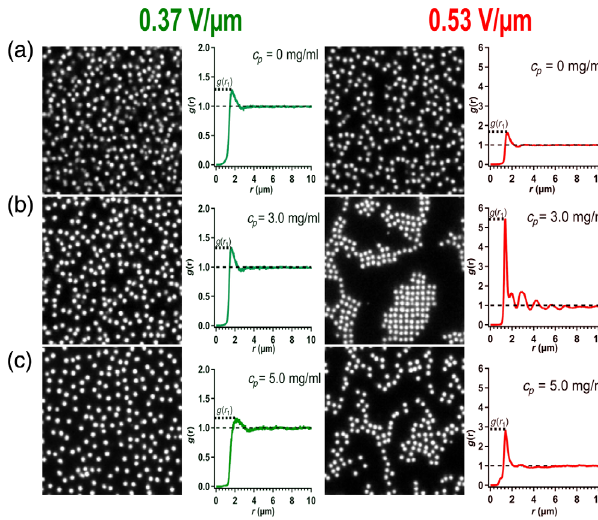
FIG. 1. Confocal images and radial distribution function [ g ð r Þ ] at different field strengths E . g ð r Þ is analyzed for a sequence of 100 ( 256 × 256 pixels) images. A region of interest of size 128 × 128 pixels is shown (each pixel has an ¼ 0 mg = ml at E ¼ 0 . 37 and extent of 0 . 276 μ m). (a) c p 0 . 53 V = μ m. (b) c ¼ 3 mg = ml at E ¼ 0 . 37 and 0 . 53 V = μ m. p ¼ 5 mg = ml at E ¼ 0 . 37 and 0 . 53 V = μ m. Height of the first (c) c p peak of g ð r Þ denoted by g ð r 1 Þ in the graphs varies with E and c p